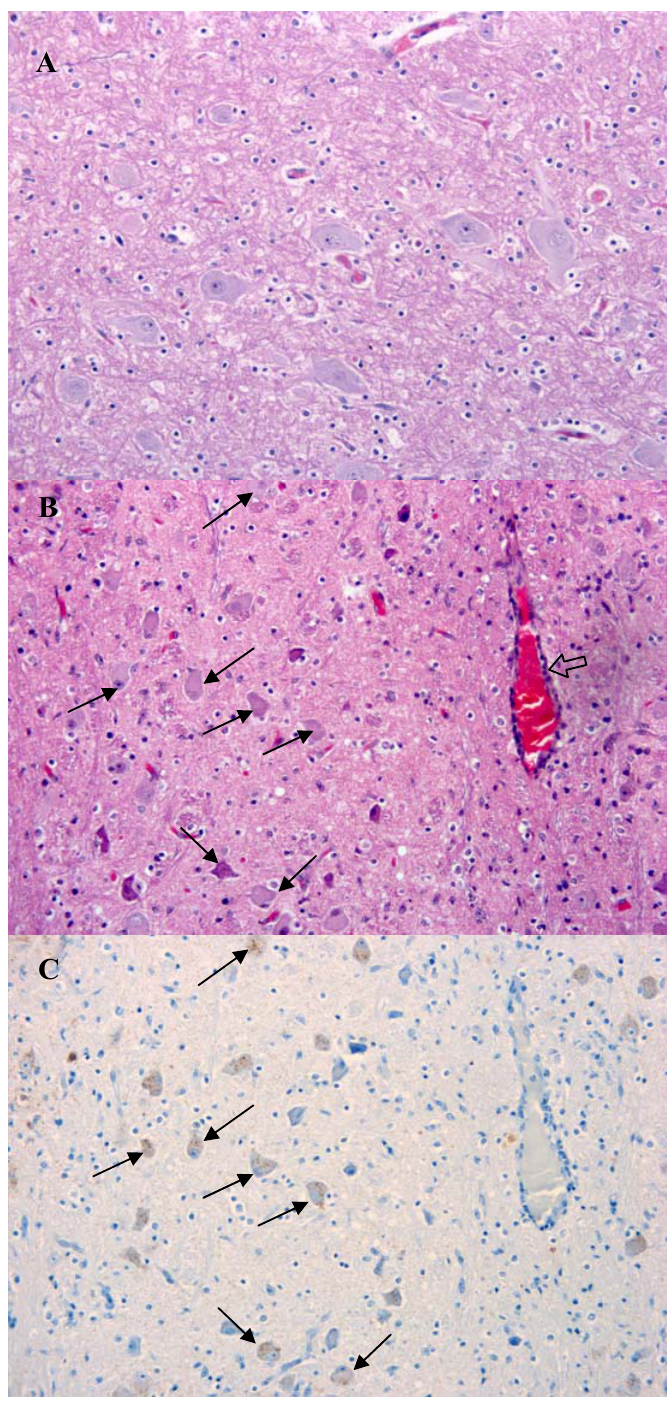
Figure 2. Pathological changes associated with rabies infection in the brain of the dog. ( A ) H & E staining of the brainstem of a normal dog. ( B ) H & E staining in the rabies positive dog. Arrows indicate central chromatolysis and nuclear margination. The block arrow indicates a perivascular cuff. ( C ) Immunohistochemistry labeling for RABV nucleoprotein as described in material and methods. Brown staining (arrows) indicate detection of RABV within neurons. Both images were taken at a magnification of